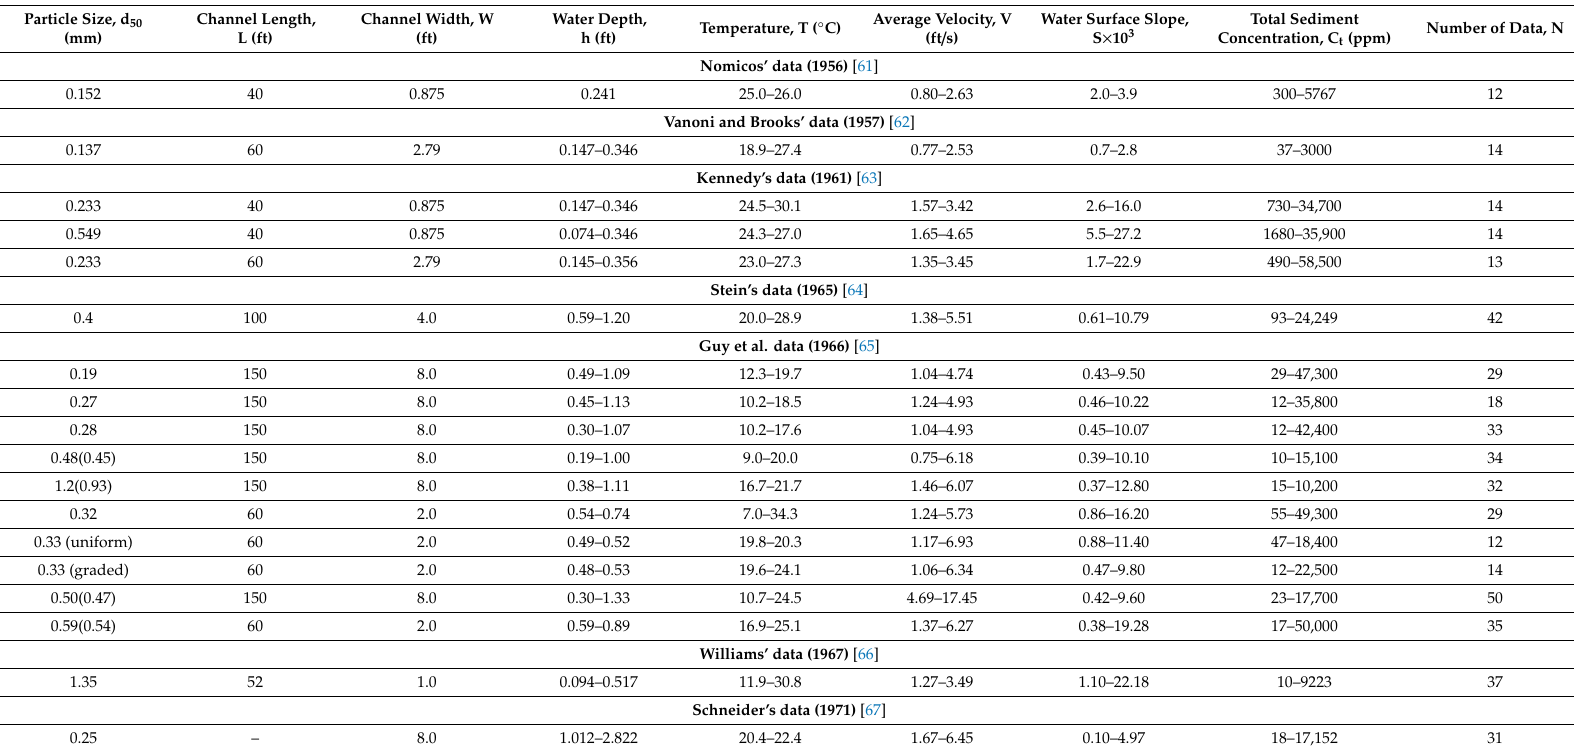
Table 1. Experimental data for unit stream power